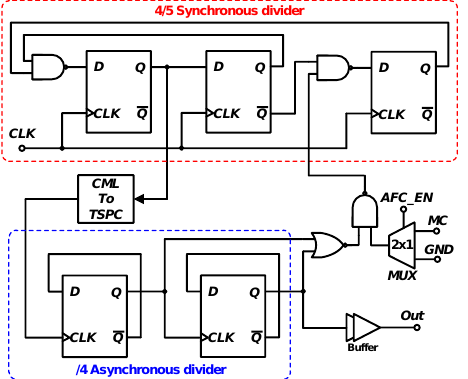
Figure 5. Schematic of the 16/17 dual-mode frequency divider.